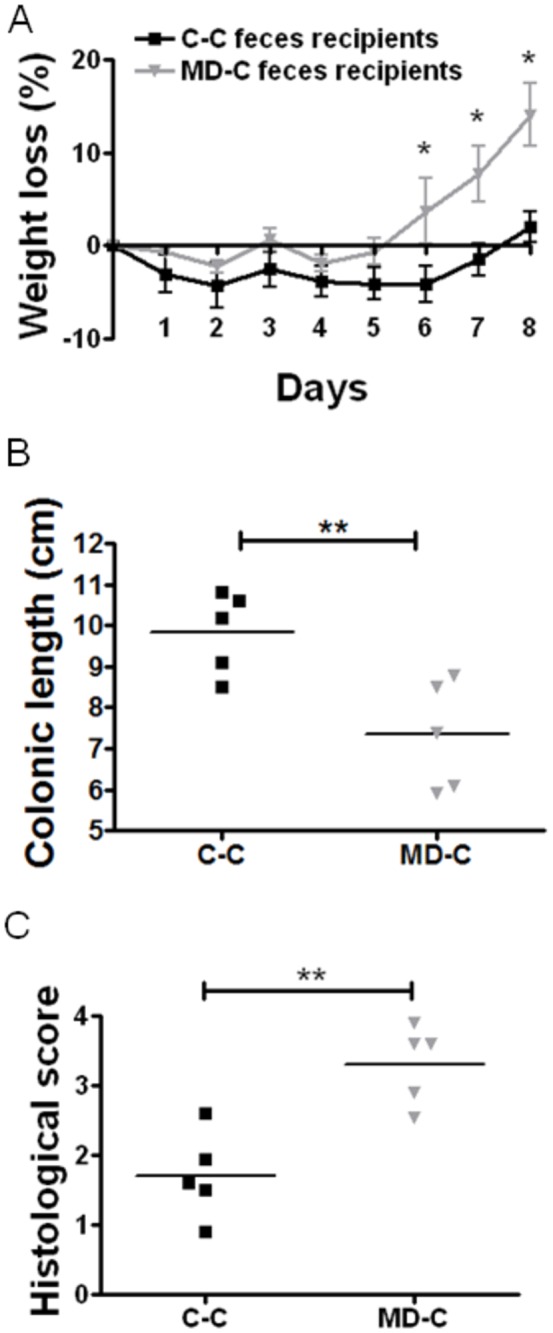
Significantly augmented colitis in germ free recipients of MD-C feces.5-5 germ free male mice were gavaged with pooled cecal content (feces) from either prenatally MD supplemented animals (MD-C), or controls (C–C). After 5 days the animals were tested for colitis susceptibility by 5% DSS exposure in drinking water for 5 days. At day 8, the mice were euthanatized. Colonic length was measured and colonic tissue was examined histologically. (A) Weight loss upon 5% DSS challenge was significantly greater in the recipients of MD-C feces at days 6, 7, and 8 (*p<0.05). (B) The increased severity of colitis was also reflected by significant colonic length shortening in the recipients of MD-C feces (p=0.0099) compared to control. (C) A greater degree of tissue damage and inflammation (p=0.0028) was observed in the MD-C fecal recipients compared to the recipients of control stool. N=5.